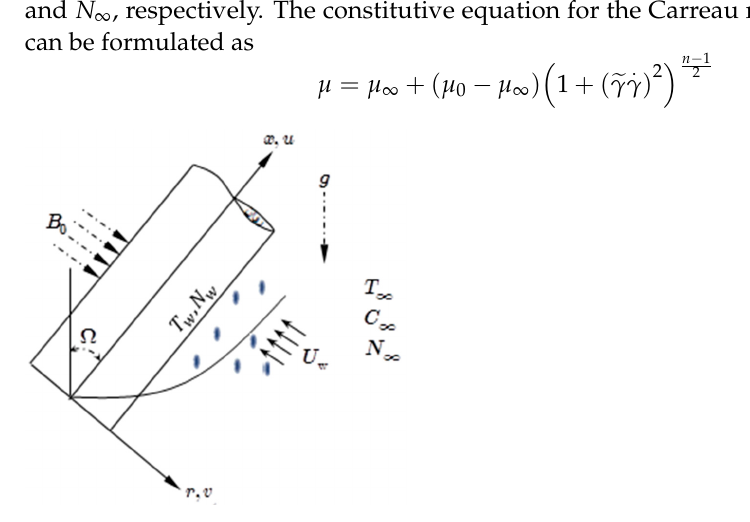
Figure 1. Physical configuration of the problem.